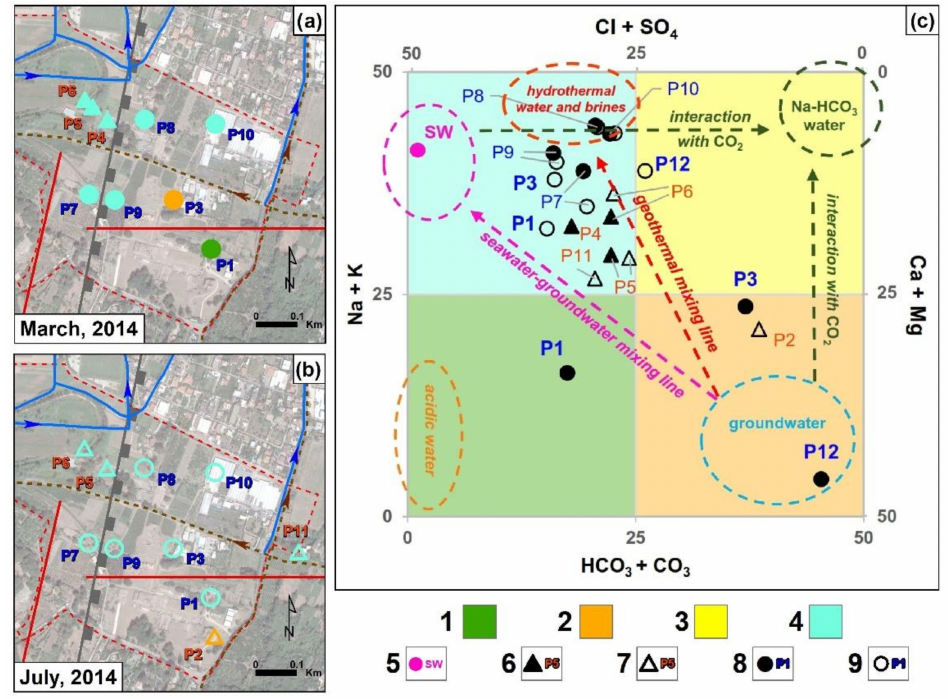
Figure 4. Spatial distribution of hydrochemical facies of shallow and deep wells, for the period ( a ) March 2014 and ( b ) July 2014, and ( c ) Langelier–Ludwig diagram. Legend: (1) CaMg-ClSO 4 type; (2) CaMg-HCO 3 type; (3) NaK-HCO 3 type; (4) NaK-ClSO 4 type; (5) sea water; (6) shallow wells in March 2014; (7) shallow wells in July 2014; (8) deep wells in March 2014; (9) deep wells in July